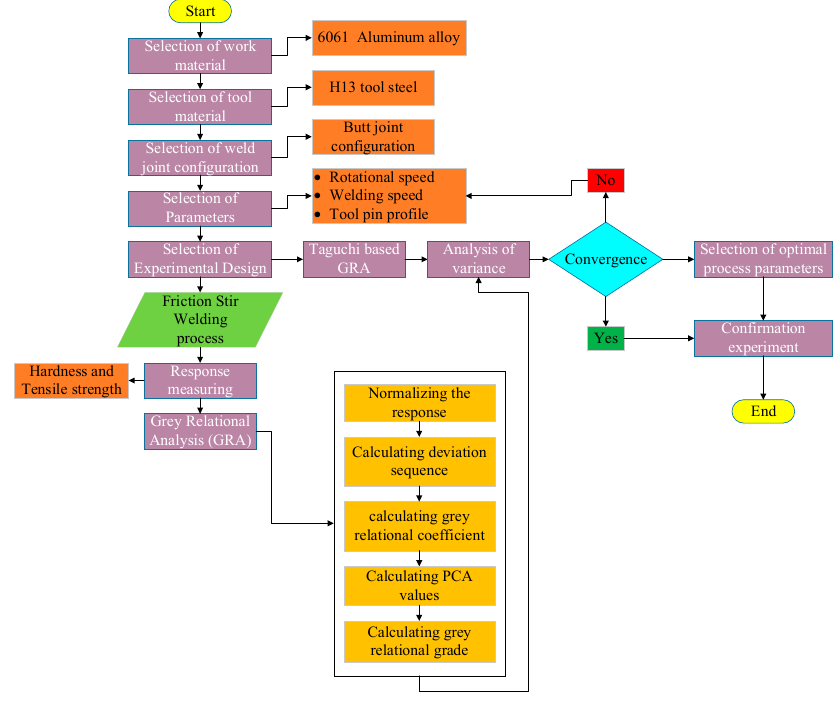
Figure 10. A research framework.